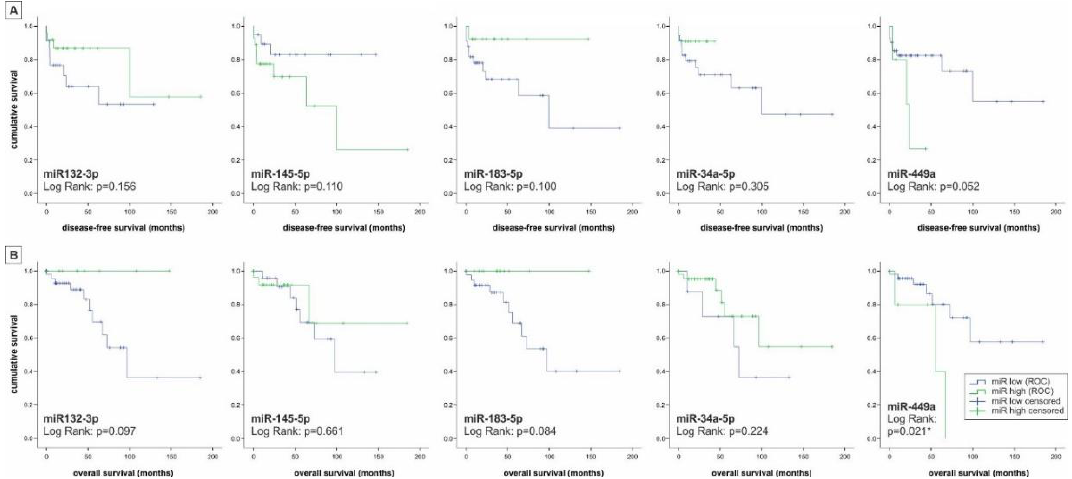
Figure 4. Survival analysis of patients with pNET. According to the classification of miRNAs in low or high based on the relative miRNA expression levels using receiver operating characteristic (ROC) calculation with Youden Index analysis the Kaplan–Meier survival analysis using the log–rank test was performed for ( A ) disease-free survival and ( B ) overall survival. “Protective miRNAs” include miRNA145-5p and miRNA183-5p, whereas “risk miRNAs” include miRNA132-3p, miRNA34a-5p, and miRNA449a. * p < 0.05, ** p < 0.01.